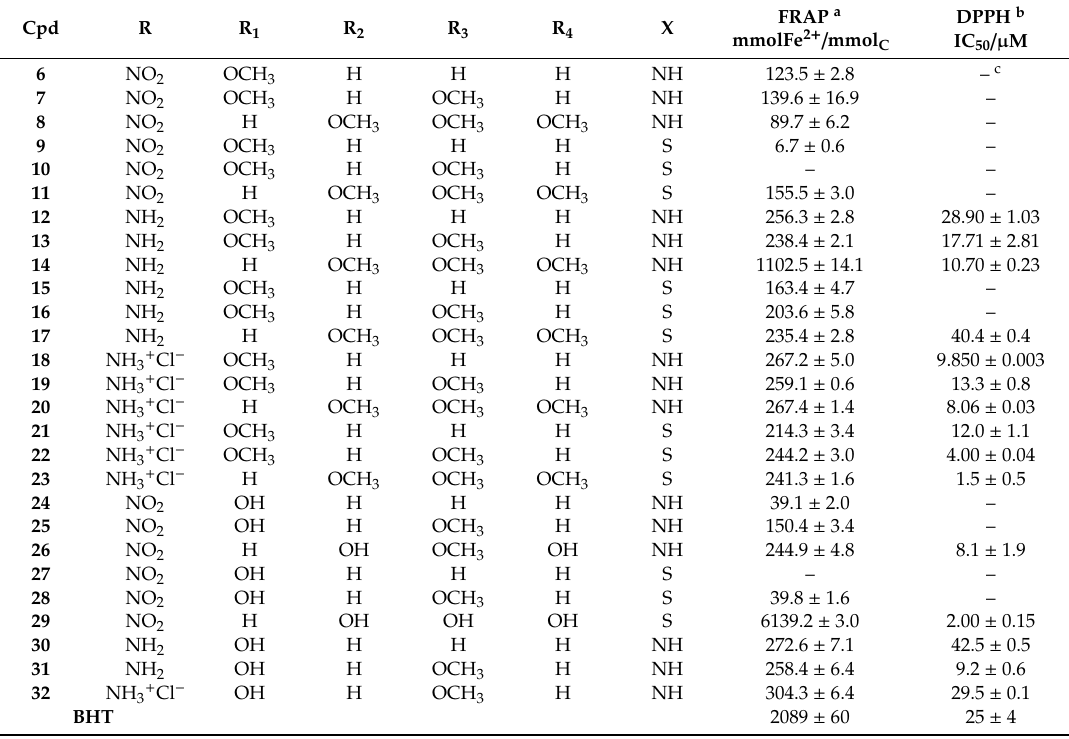
Table 2. IC 50 values for 1,1-diphenyl-picrylhydrazyl (DPPH) free radical scavenging and ferric reducing / antioxidant power (FRAP)